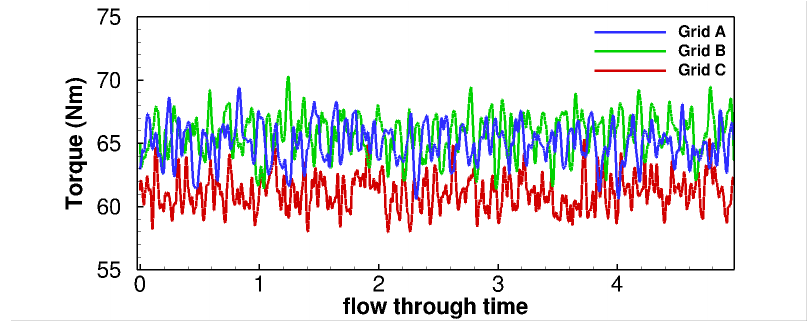
Figure 14. Time histories of torque in the axial direction on the rotating parts for Grids